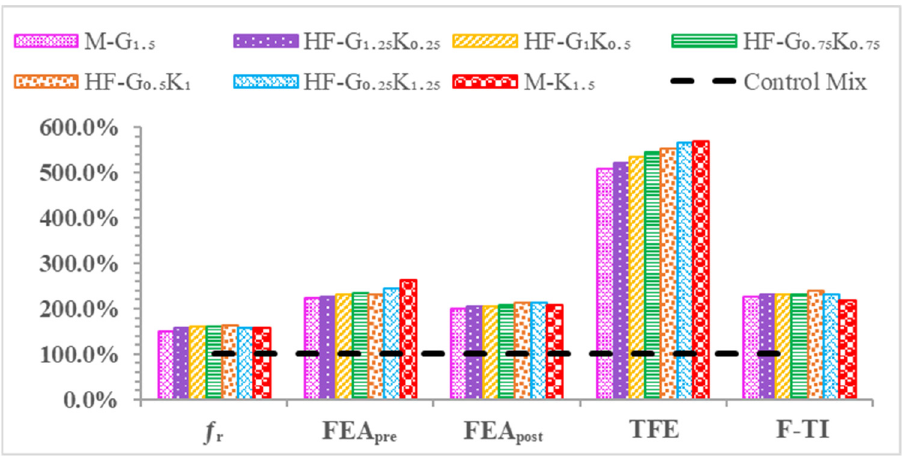
Figure 9. Percentage comparison of concrete properties under flexural loading.